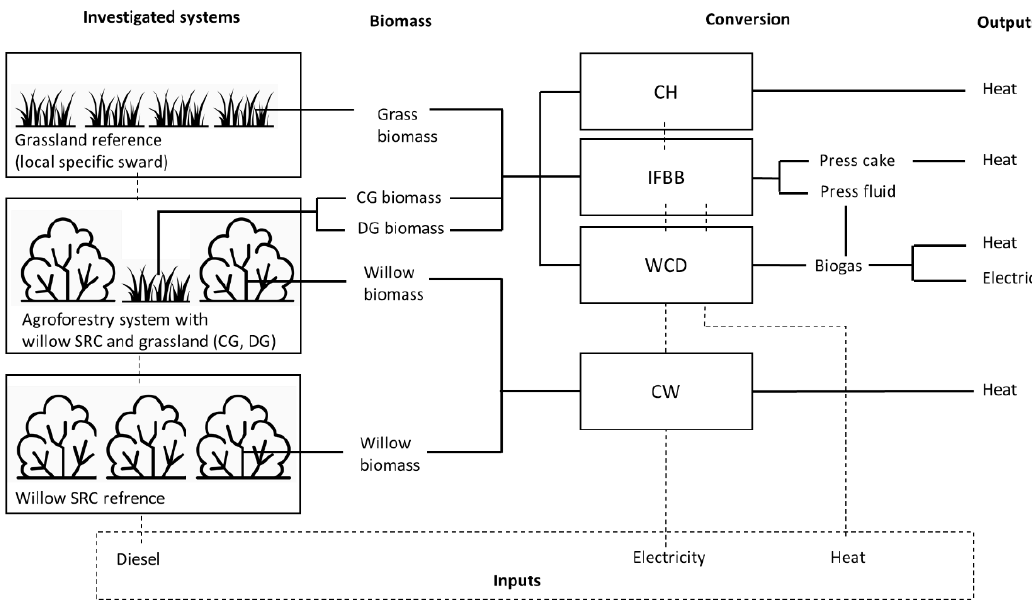
Figure 2. General framework of investigated systems, biomass sources (CG = clover grass; DG = diverse grassland mixture, SRC = short rotation coppice) and energy conversion pathways (CH = combustion of hay, IFBB = integrated generation of solid fuel and biogas from biomass, WCD = anaerobic whole crop digestion, CW = combustion of willow woodchips).